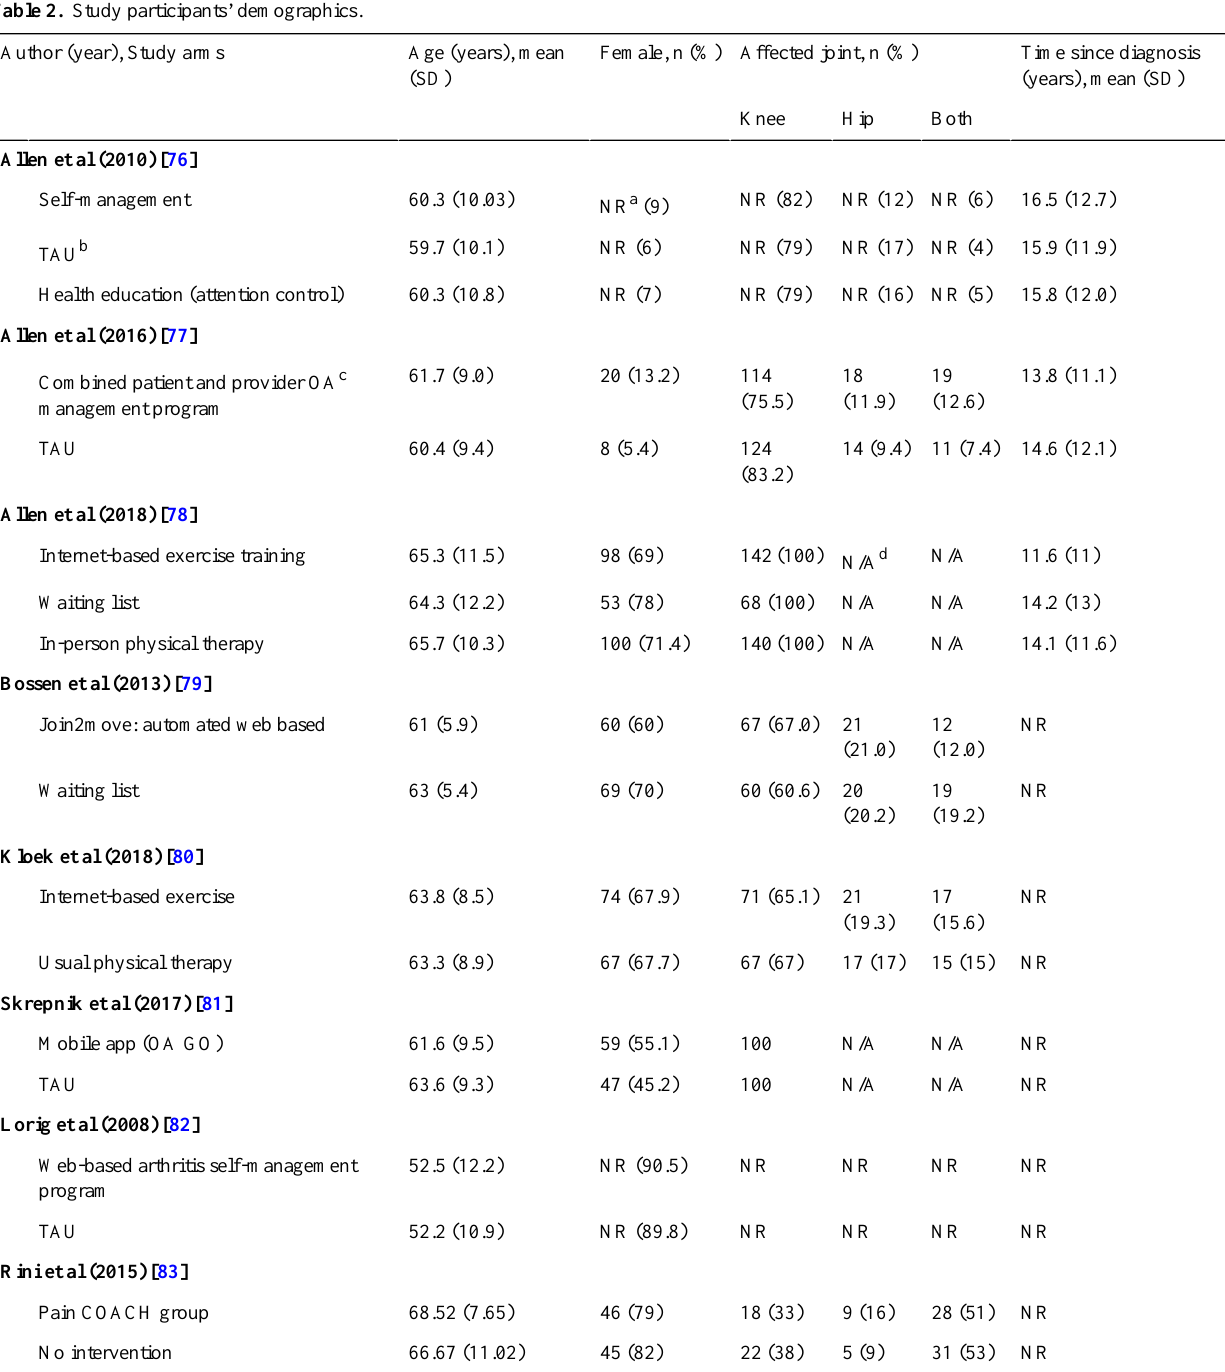
Table 2. Study participants’demographics.